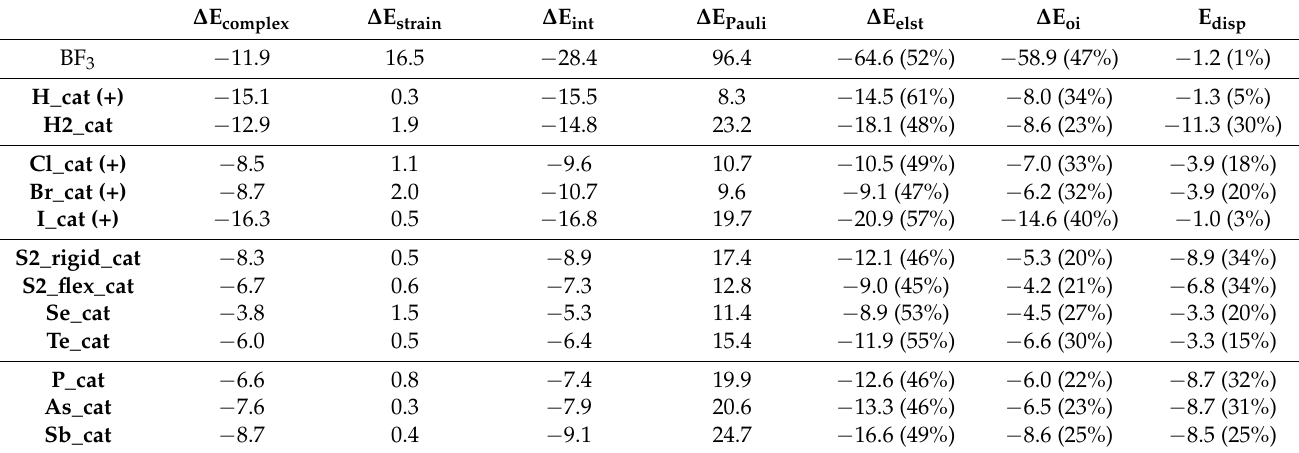
Table 2. Energy decomposition analysis for the reactant complexes formed between benzaldehyde and the set of catalysts. All energies are denoted in kcal mol − 1 . The numbers between brackets indicate the relative contribution of each energy component to the stabilizing part of the total interaction